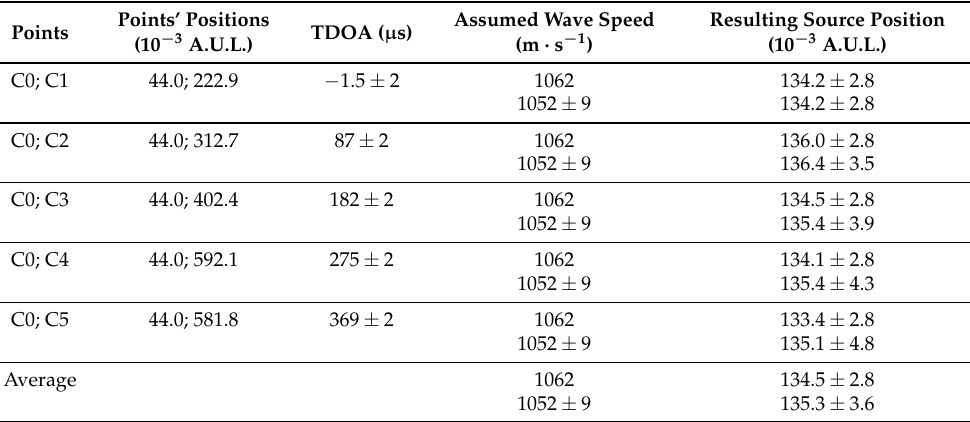
Table 3. Multi-sensor localization with points in the main section—results (actual source position: 135.3 × 10 − 3 A.U.L.).